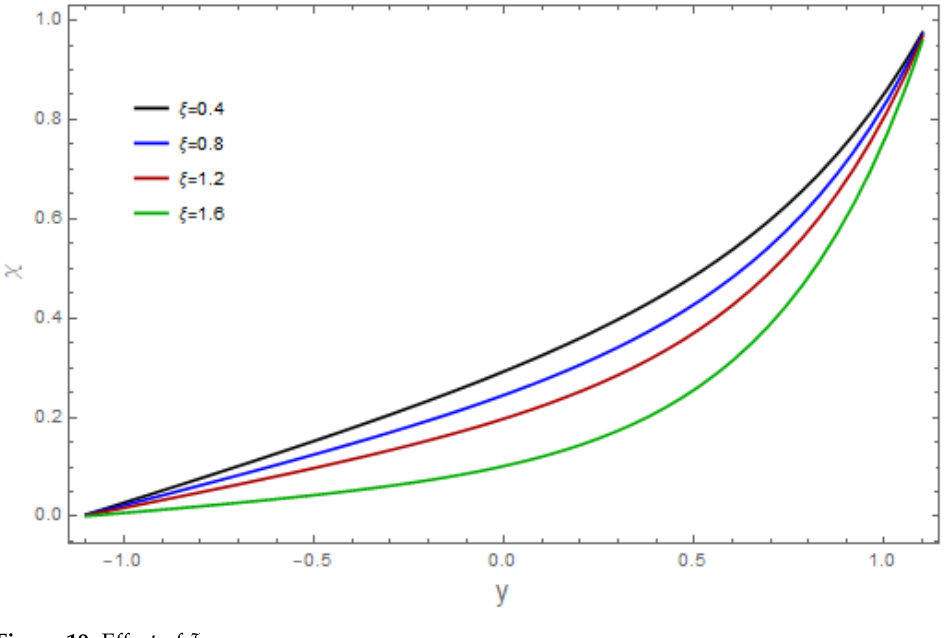
Figure 19. Effect of 𝜉 on 𝜒 .